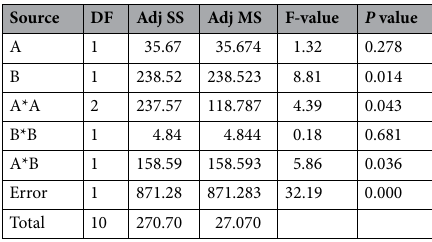
Table 4. ANOVA for impact strength.